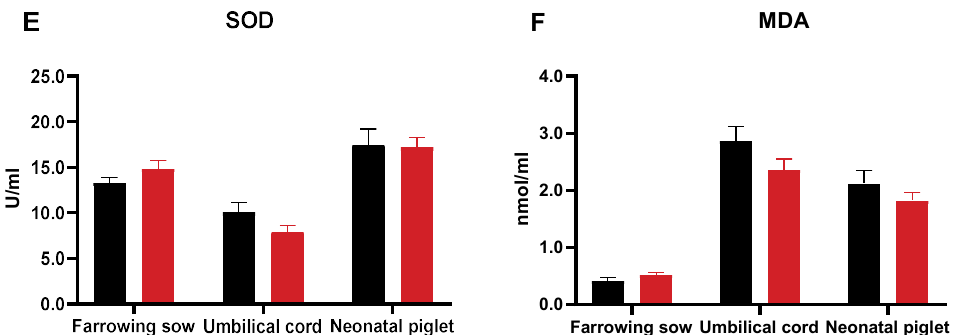
Figure 1. Antioxidant enzyme activities in serum of farrowing sows, umbilical cords, and neonatal piglets. ( A ): glutathione (GSH) activity; ( B ): catalase (CAT) activity; ( C ): Total antioxidant capacity (T-AOC); ( D ): Peroxidase (POD) activity; ( E ) Superoxide dismutase (SOD) activity; ( F ): Malondialdehyde levels (MDA). Data are presented as mean ± SEM, n = 8. Statistical significance was set at p < 0.05. * Labeled with significant difference ( p < 0.05).